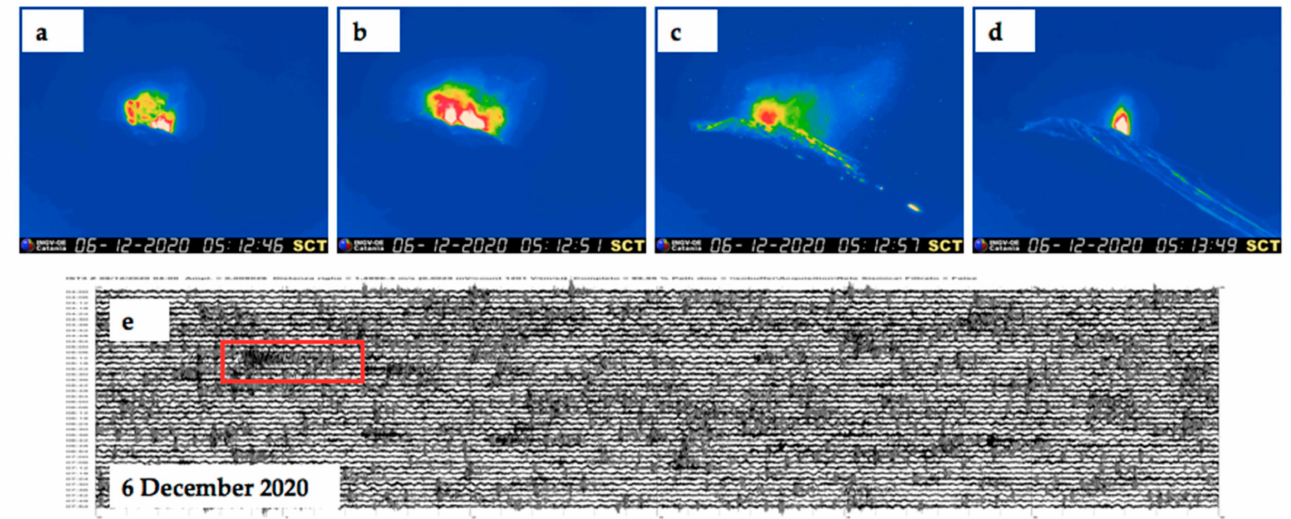
Figure 14. ( a – d ) Thermal images from the SCT camera of the 6 December 2020 event, view from NE, with ( e ) the corresponding seismic trace, indicated by the red box. In the thermal images blue is cold, white is